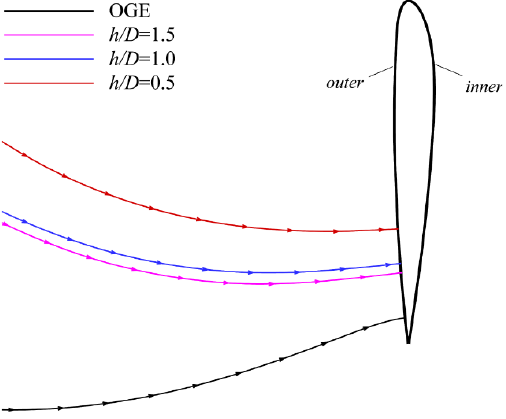
Figure 20. Stagnation streamlines of duct section at Ψ = 22.5°.